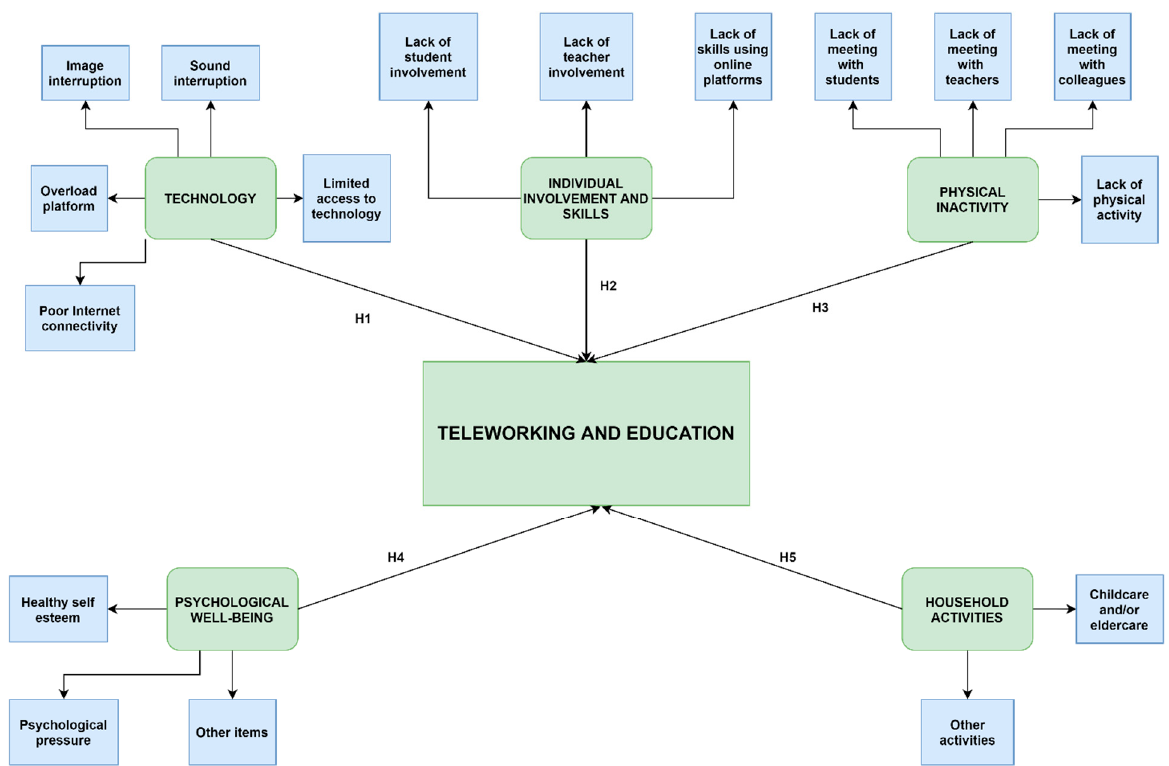
Figure 1. Research model .